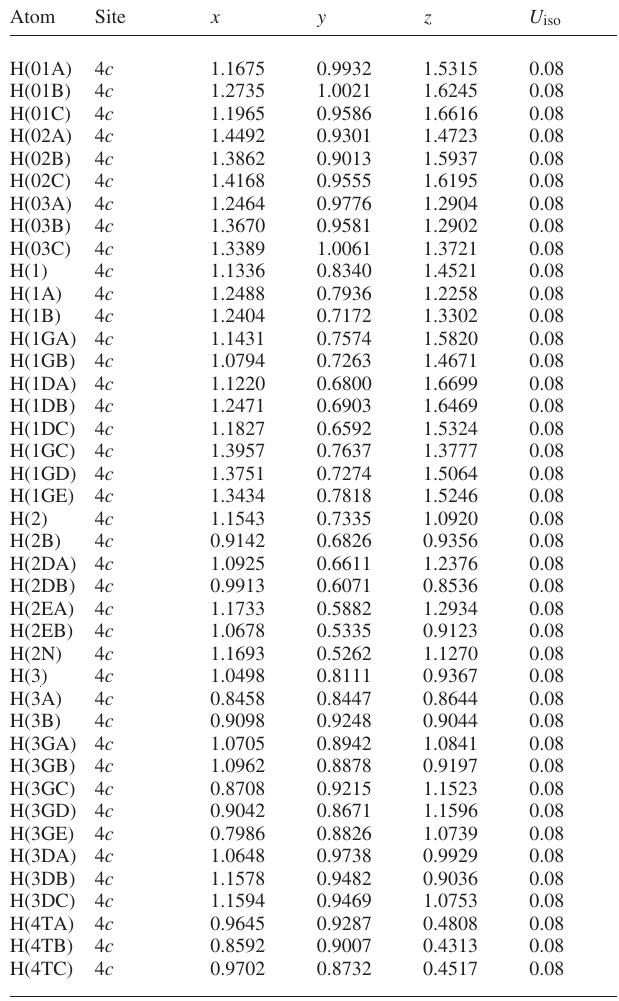
Table 2. Atomic coordinates and displacement parameters (in Å 2 )